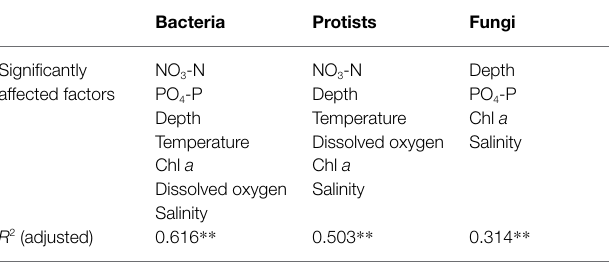
TABLE 1 | Environmental factors shaping bacterial, protist, and fungal communities, as revealed by RDA analysis. Bacteria Protists